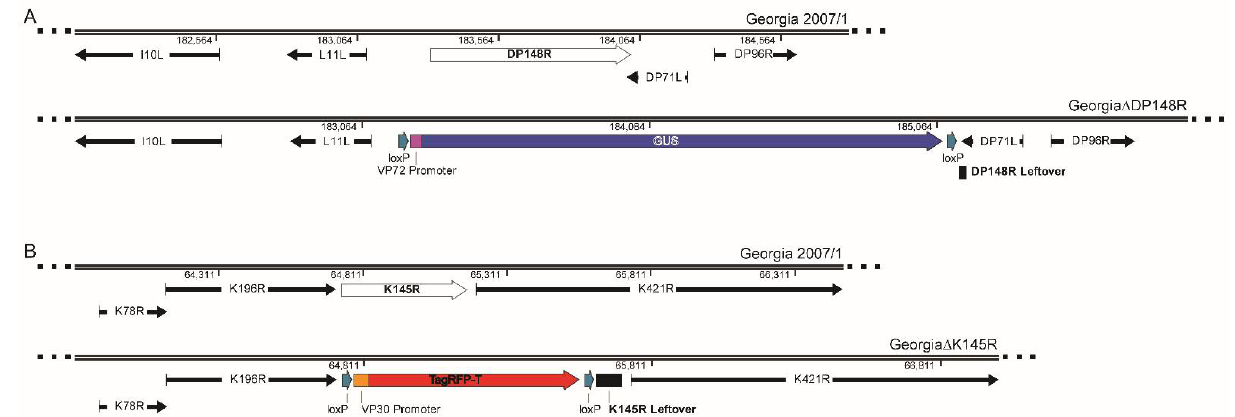
Figure 1. Schematic diagram depicting the deletion of DP148R and K145R. ( A ) ASFV Georgia 2007/1 genotype II strain (accession number: FR682468.1) is shown from position 182,064–184,800. The gene DP148R is deleted from position 183,187 to 184,012 and replaced with the reporter gene, GUS, driven by the ASFV P72 promoter. ( B ) ASFV Georgia 2007/1 is shown from position 63,811 to 66,473. The gene K145R is deleted from 64,734 to 65,086, leaving behind 85 bp of K145R on the 3′ end. This deletion is replaced by the fluorescent reporter, TagRFP-T driven by the ASFV VP30 promoter. Gene maps were designed using SnapGene ® Viewer software (GSL Biotech, San Diego, CA, USA) and modified on Adobe ® Illustrator ® CS6 (Adobe Systems Inc. San Jose, CA, USA).